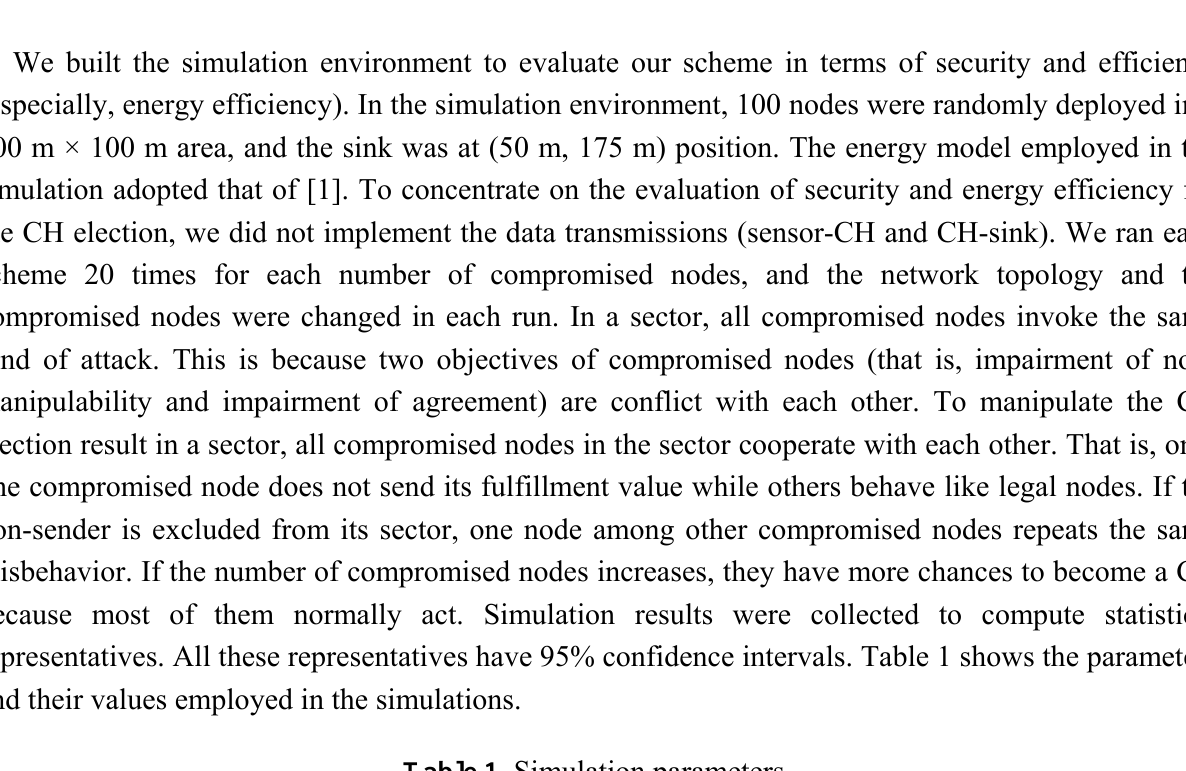
Table 1. Simulation